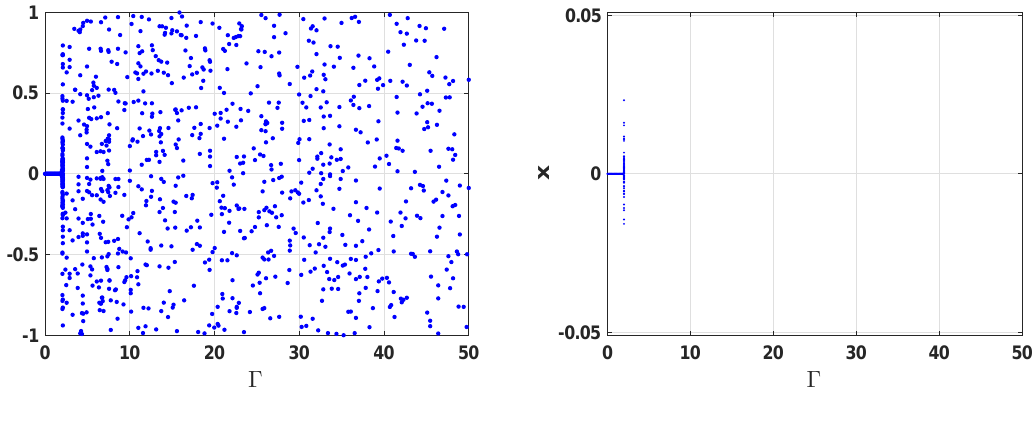
Fig. 4 Bifurcation diagrams in case of c = 0 . 5, ω = 1, e = 0 (left) and e = 0 . 1